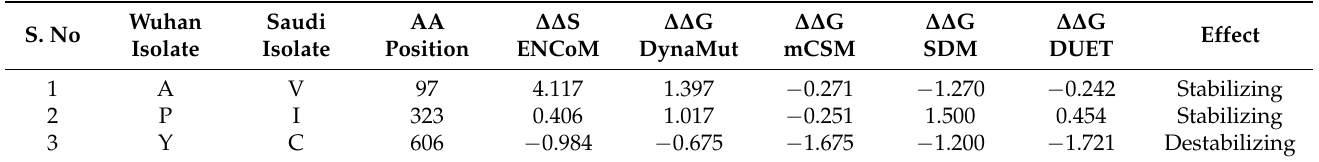
Table 3. The values of change in ΔΔS ENCoM and ΔΔG (kcal/mol) due to the mutations in RdRp.